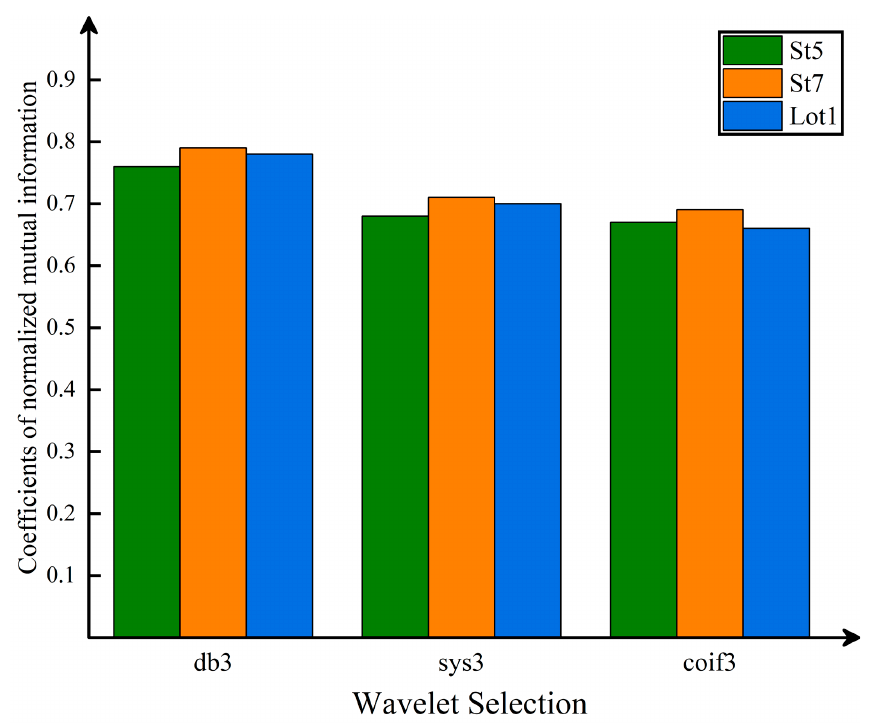
Figure 5. Wavelet selection based on normalized mutual information.